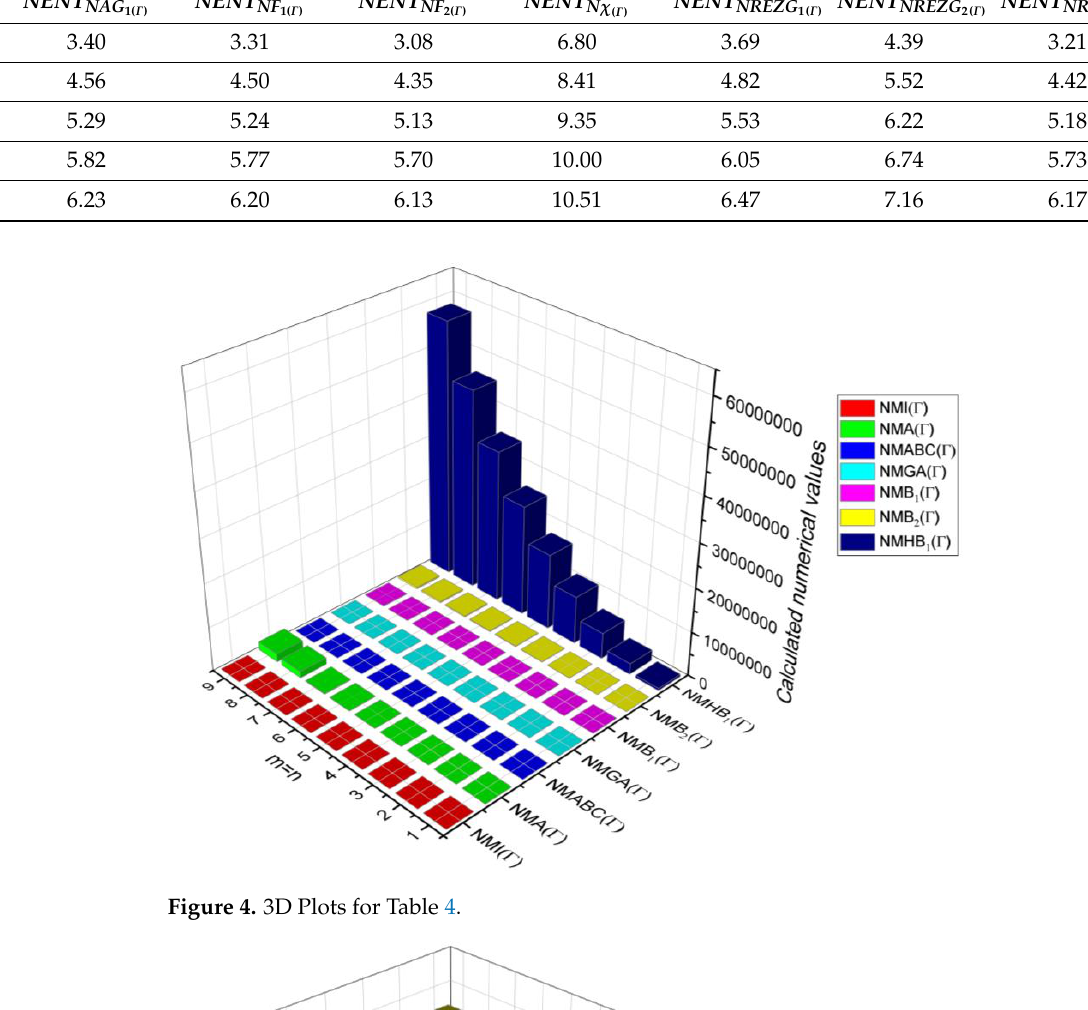
Table 4. Comparison Table for Theorem 2.